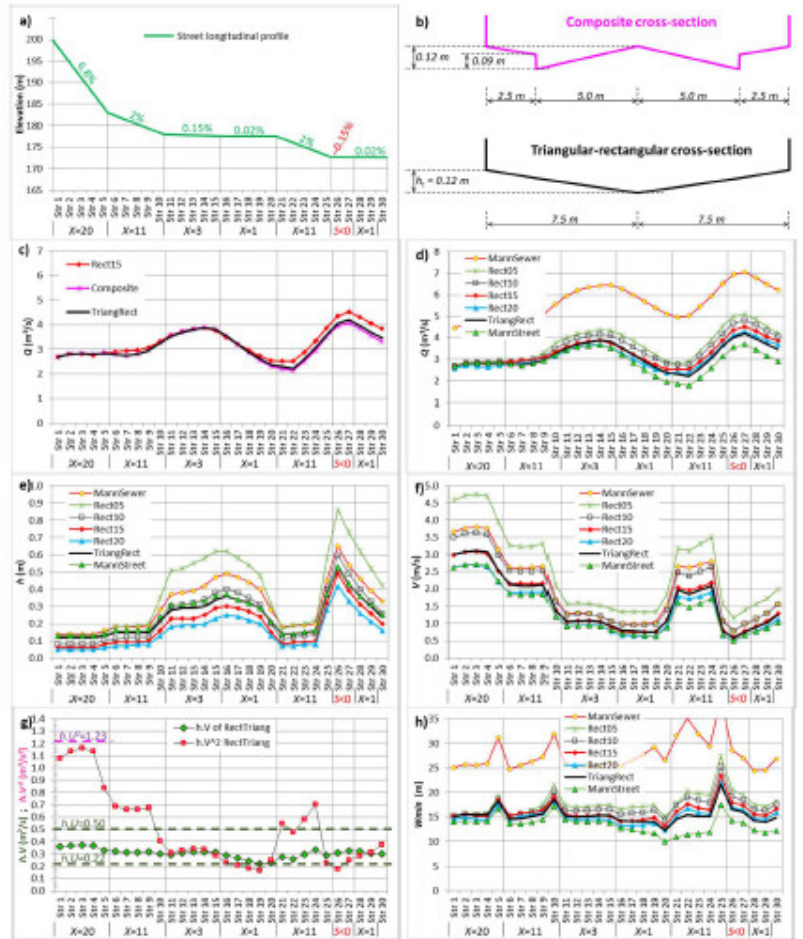
Figure 6. Results from the case study: ( a ) Street longitudinal profile; ( b ) Dimensions of used composite and triangular-rectangular cross-sections; ( c , d ) flood maximum flows along the street; ( e ) flood maximum depths along the street; ( f ) flood maximum velocities along the street; ( g ) maximum values of criteria A and B along the street; ( h ) minimum street widths calculated by the expedited method as a function of the flow rates (actual width is 15 m).